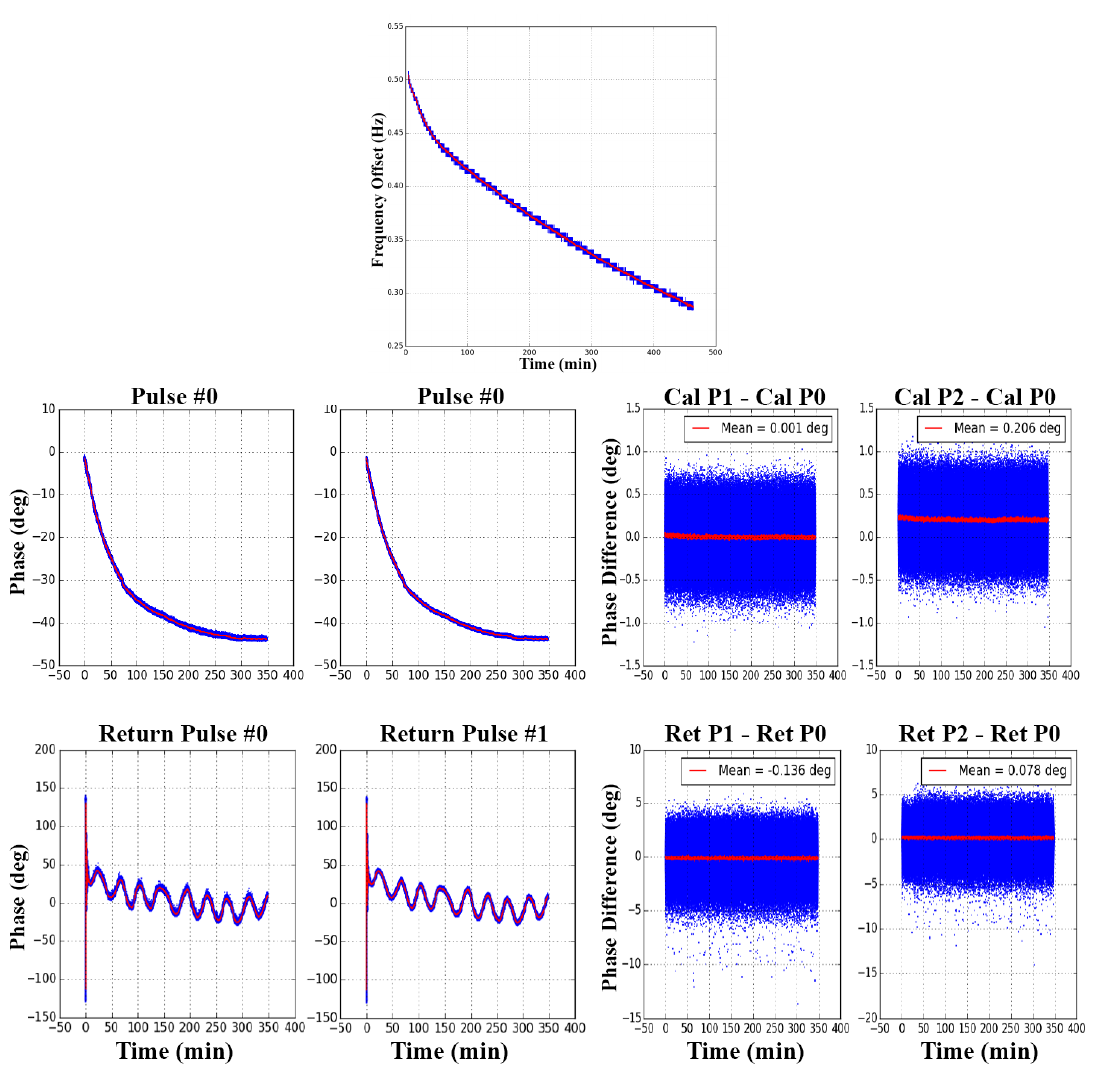
Figure 6. Top: Drift of the 10 MHz STALO over time during lab testing. Left 4-panels: Phase variation of the calibration pulses ( top ) and the return pulses ( bottom ) from the FODL. Right 4-panels: Pulse phase difference between the calibration pulses and the return